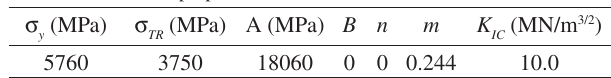
Table 1. Mechanical properties of WC-6Co 2,6 .